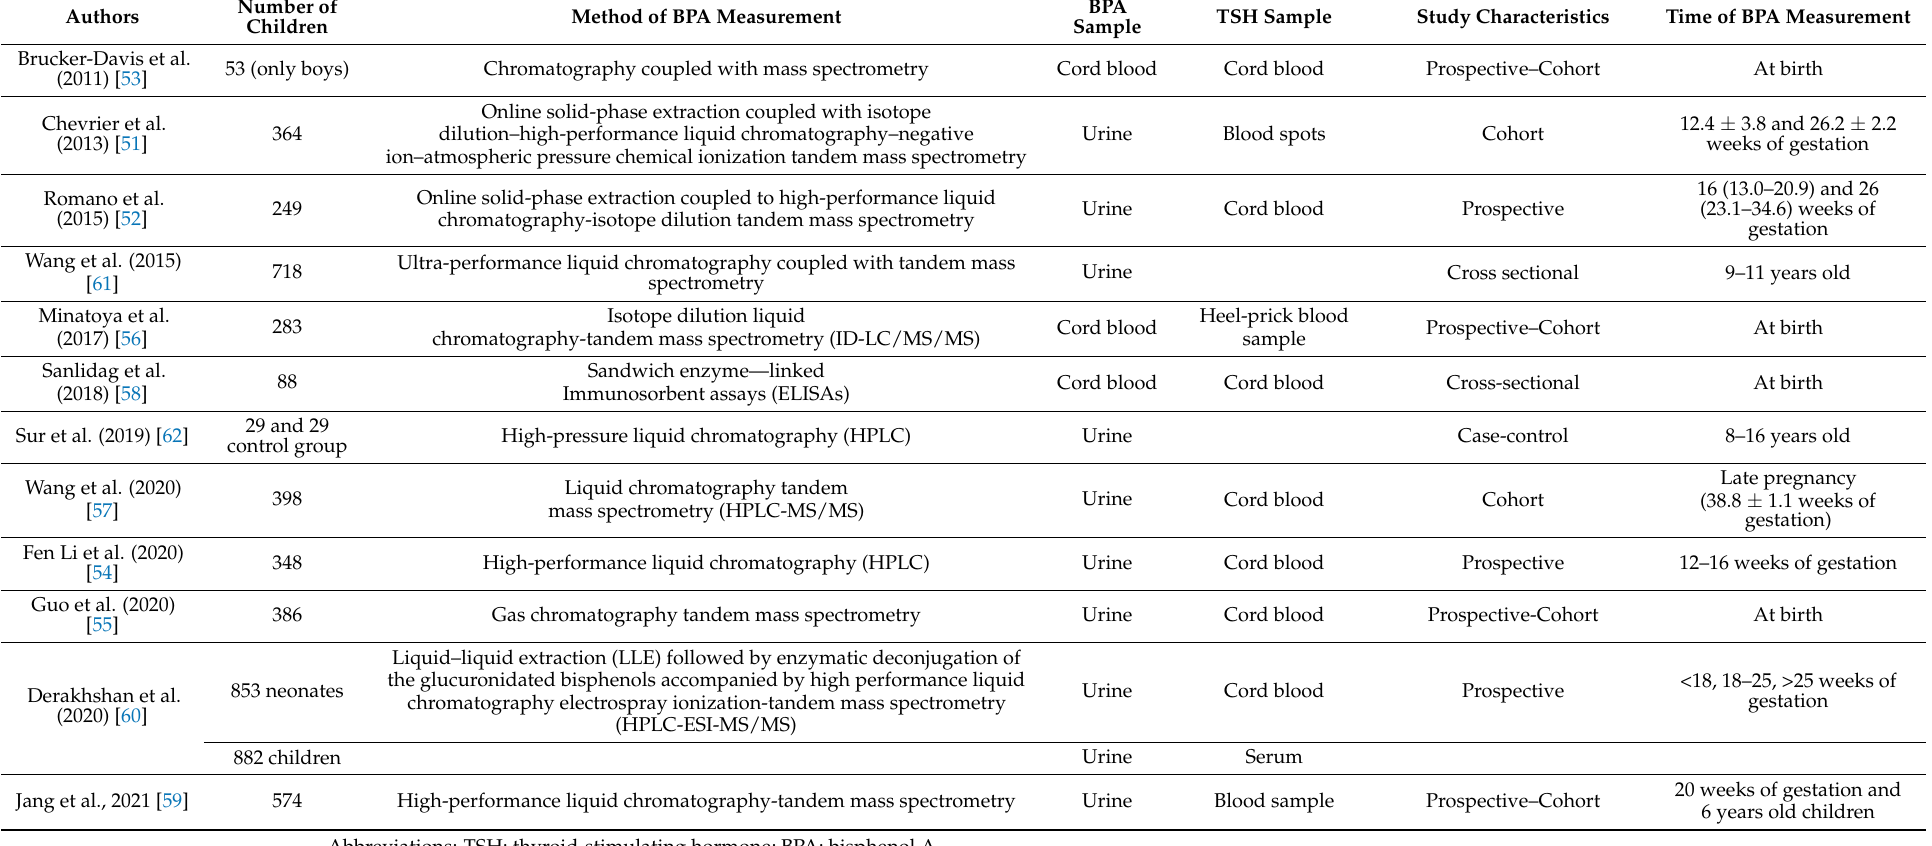
Table 2. General characteristics of included studies.